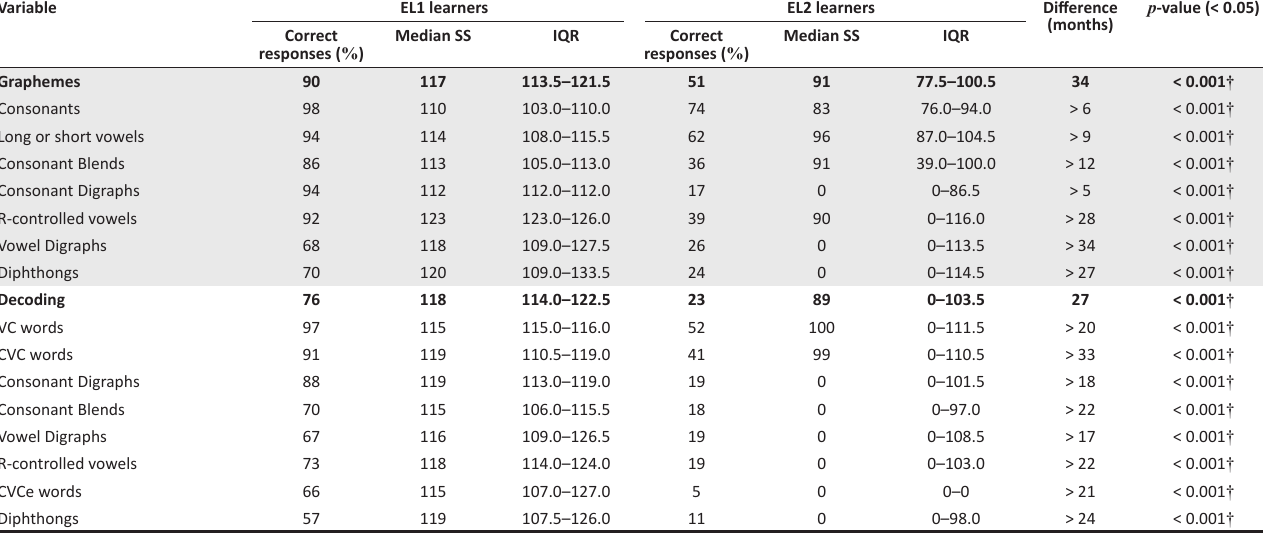
TABLE 3: Comparison of scores for English first language and English second language learners in the sub-sections of the PAT- 2: Phoneme-Grapheme Knowledge